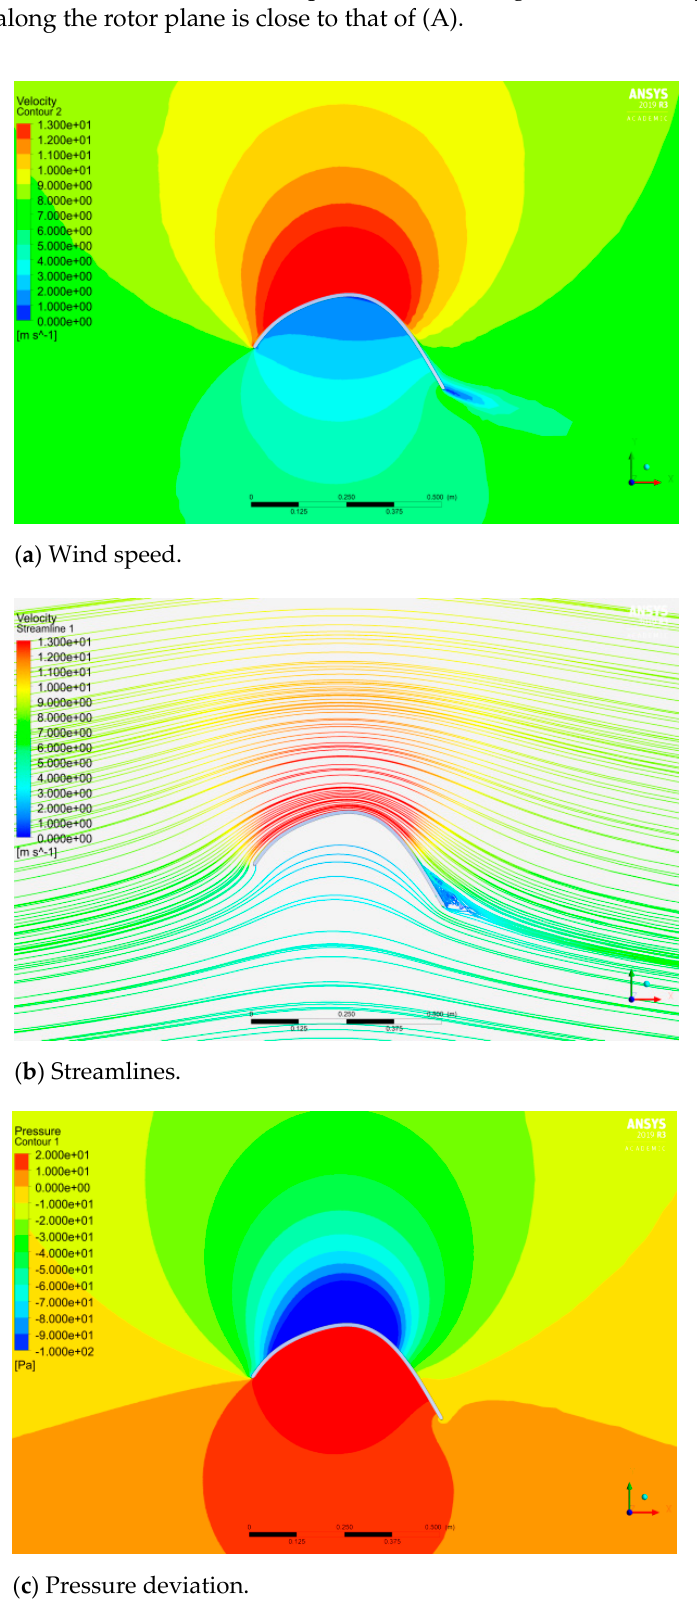
Figure 6. CFD results of the max. speedup ratio case (A) (7 m/s wind from left, top to inside the diffuser) .